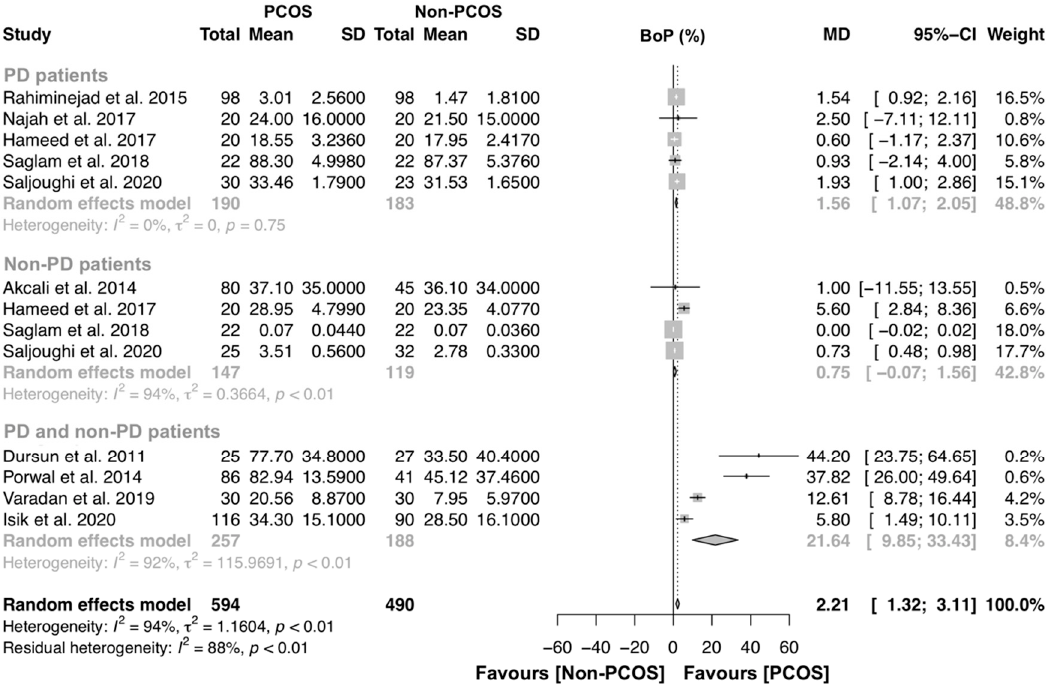
Figure 4. Forest plot of studies evaluating bleeding on probing (BoP) levels in non-PD patients with and without PCOS (p-value < 0.0001). Mean effect size estimates have been calculated with 95% confidence intervals and are shown in the figure. Area of squares represents sample size, continuous horizontal lines and diamonds width represents 95% confidence interval. Diamond and the vertical dotted line represent the overall pooled estimate.